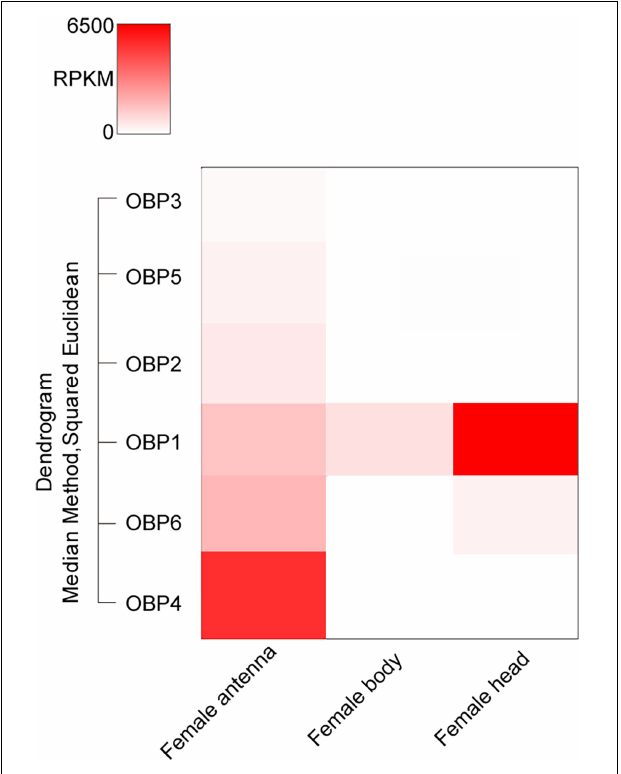
FIGURE 1 | Expression patterns of annotated OBP genes in tested Trissolcus japonicus